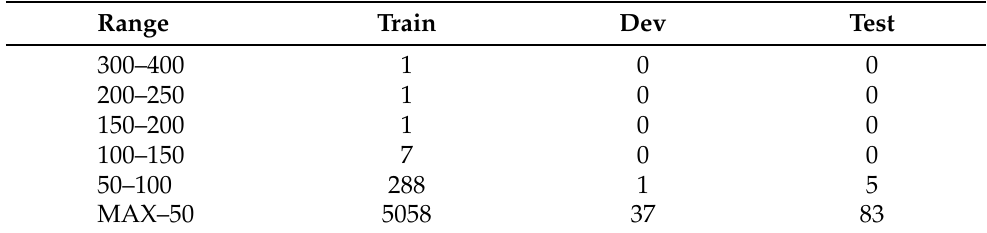
Table 6. Outlier distribution per duration range (seconds). MAX indicates the maximum value excluding outliers as computed for each partition.